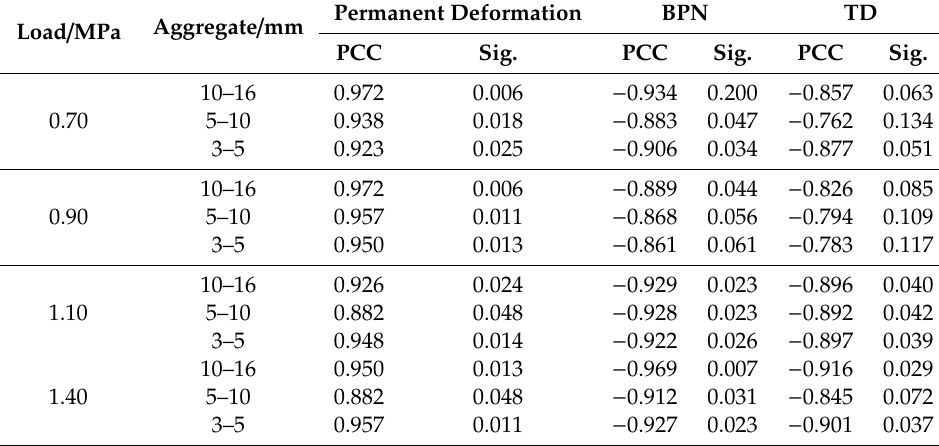
Table 4. Correlation between gradation and mixture